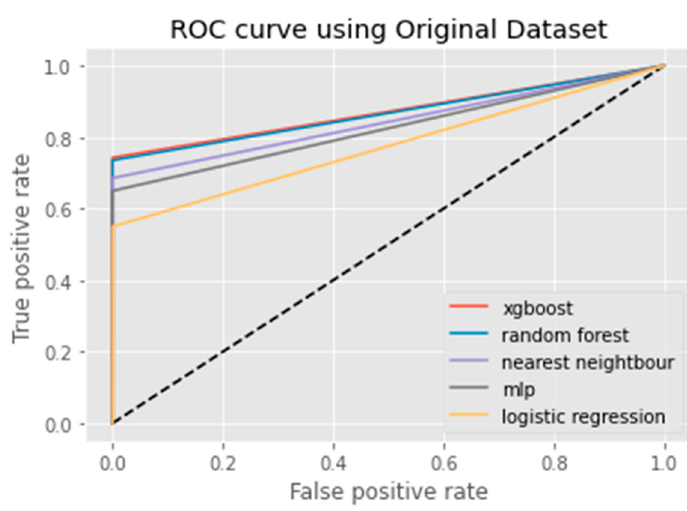
Figure 3. ROC curve of Original Dataset.